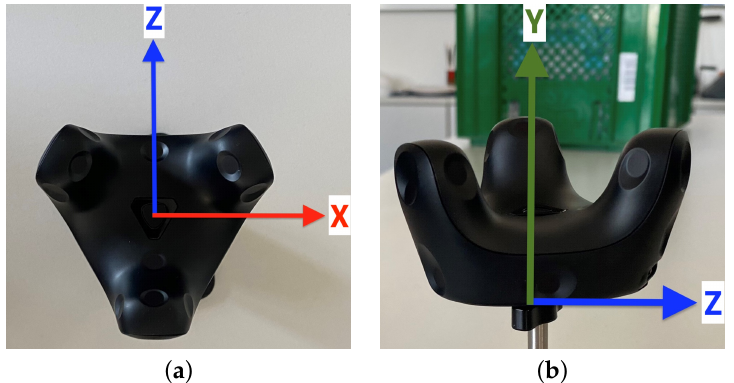
Figure 1. VIVE Tracker (3.0) with its coordinate system: ( a ) Top view with X- and Z-axis. ( b ) Side view with Y- and